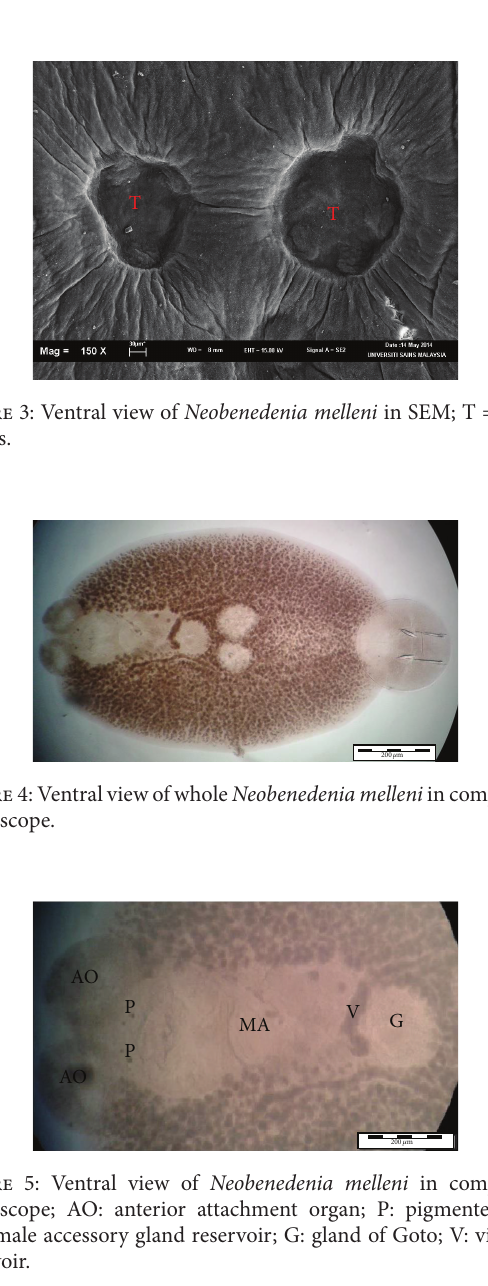
Figure 1: Ventral view of whole in SEM, Neobenedenia melleni . Figure 2: Ventral view of Neobenedenia melleni in SEM; AS: accessory sclerite; 40 𝜇 m.